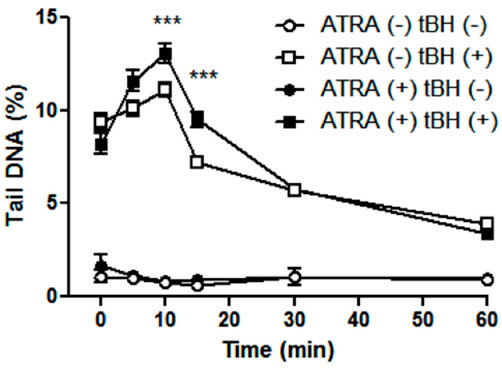
Figure 3. Time course of DNA repair in ATRA-treated and control ARPE-19 cells exposed to 180 μ M tert -butyl hydroperoxide (tBH) for 15 min at 37 °C. After the exposure, the oxidant was washed out and the cells were incubated in medium at 37 °C for indicated time points. DNA damage was assessed as percentage of tail DNA in the comet in the alkaline version of the comet assay. Results are presented as mean ± SEM, n = 100, *** p < 0.001.